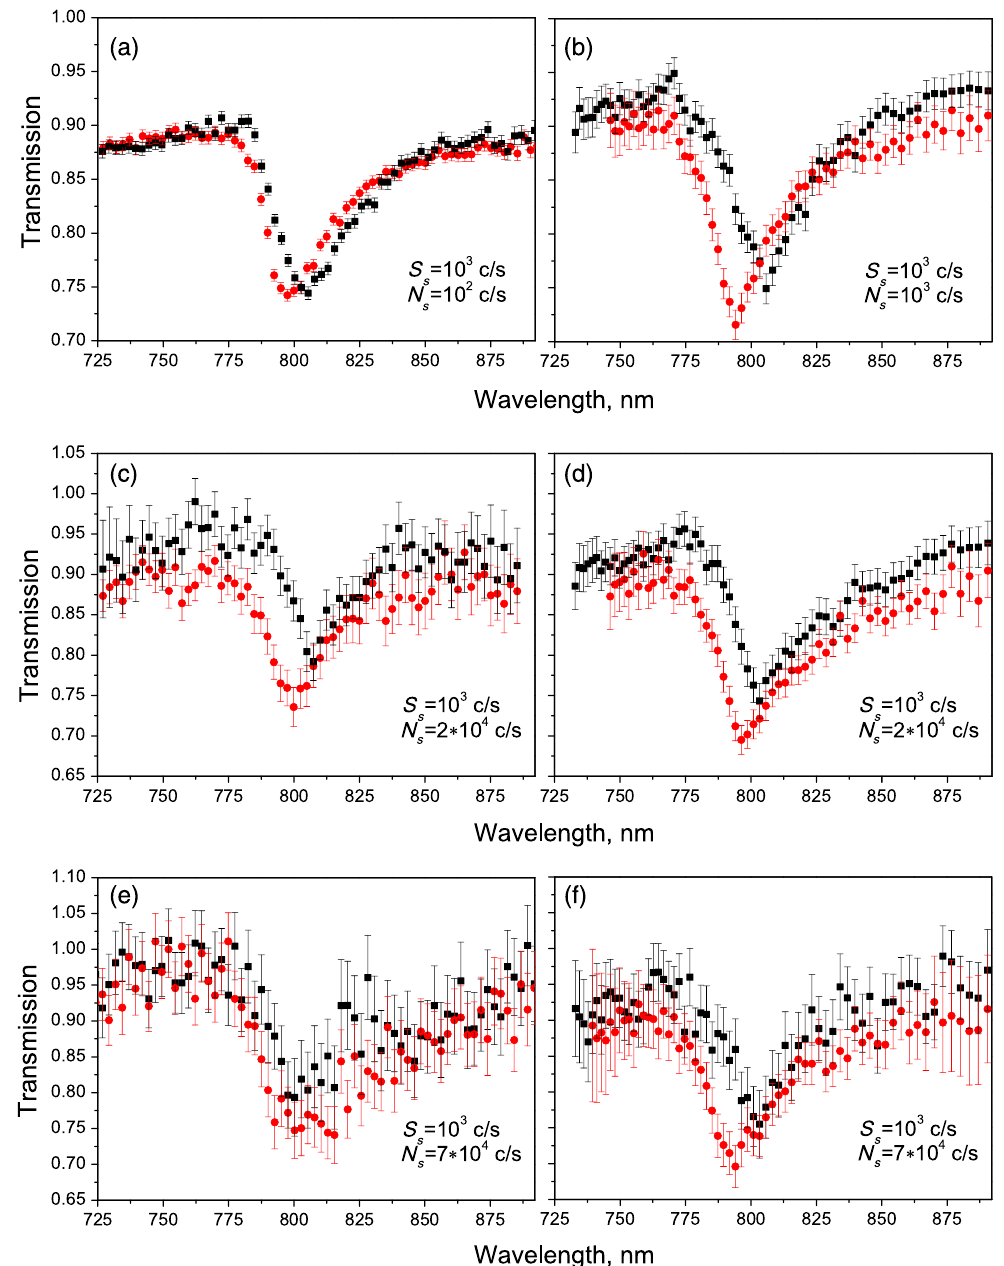
FIG. 5. Transmission spectrum of the nanoparticle array with different concentrations of glycerin-water solution on top, measured at different noise conditions. Red circles correspond to 40% glycerin concentration and black squares are assigned to 50% glycerin concentration. Results in (a), (c), and (e) are obtained by the conventional transmission spectroscopy with different noise levels of 10 2 photocounts = s, 2 × 10 4 photocounts = s, and 7 × 10 4 photocounts = s, respectively. Results in (b), (d), and (f) are obtained by the quantum spectroscopy with different noise levels: 10 3 photocounts = s, 2 × 10 4 photocounts = s, and 7 × 10 4 photocounts = s, respectively. The signal in the channel with the monochromator is the same for all the experiments in (a)-(f) and is equal to 10 3 photocounts = s. The error bars are the standard